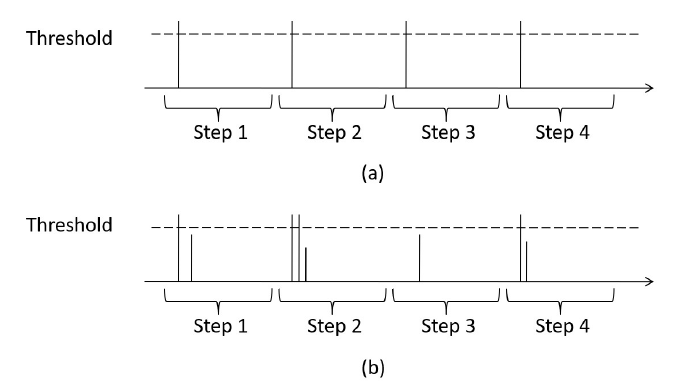
Figure 8. ( a ) Ideal Case of SC Loose definition; ( b ) Bad Case Needs SC Strict definition.